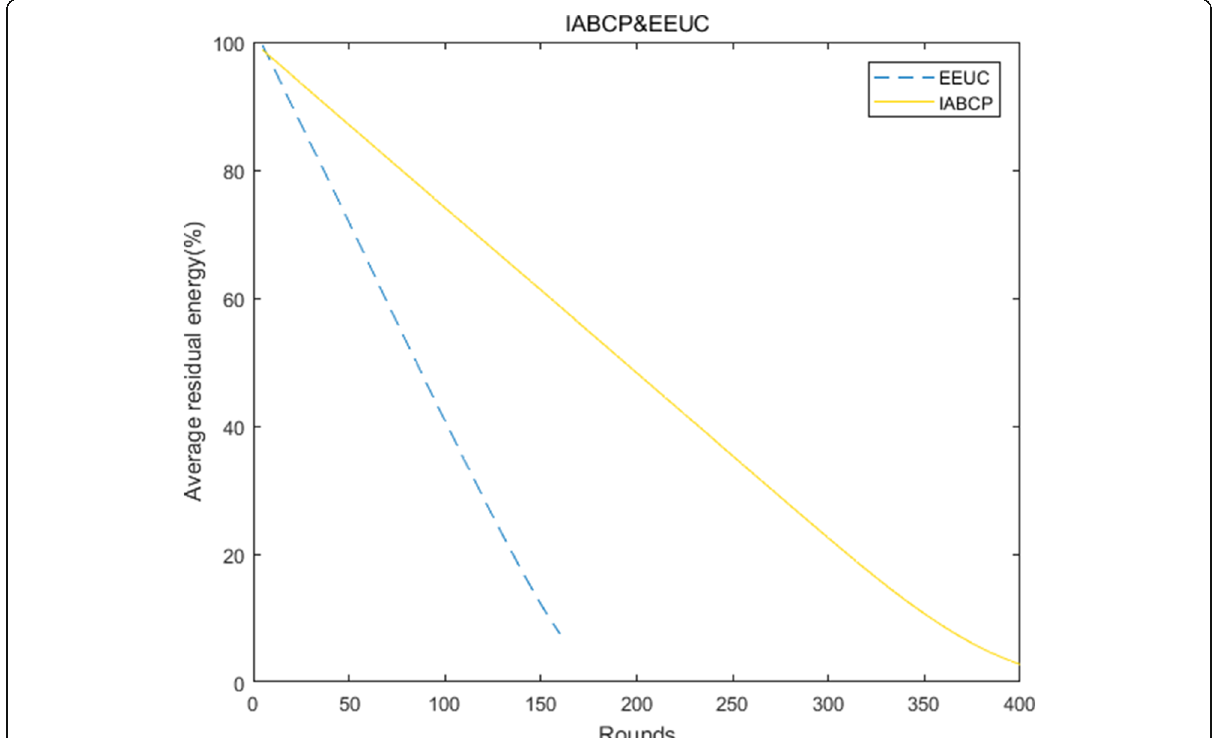
Fig. 10 Curves of the average residual energy of nodes. It mainly shows the changes of the average energy of the nodes in the network during the process of gradually dying until half of the nodes